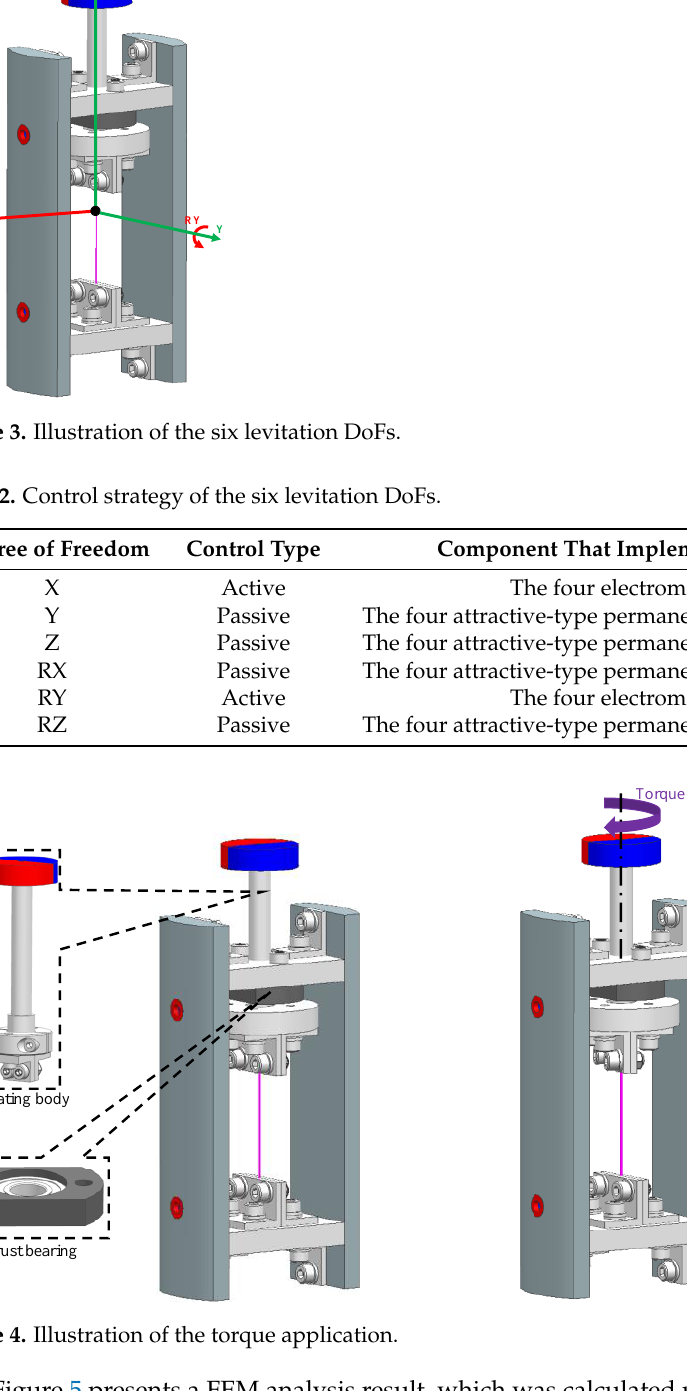
Figure 4. Illustration of the torque application.